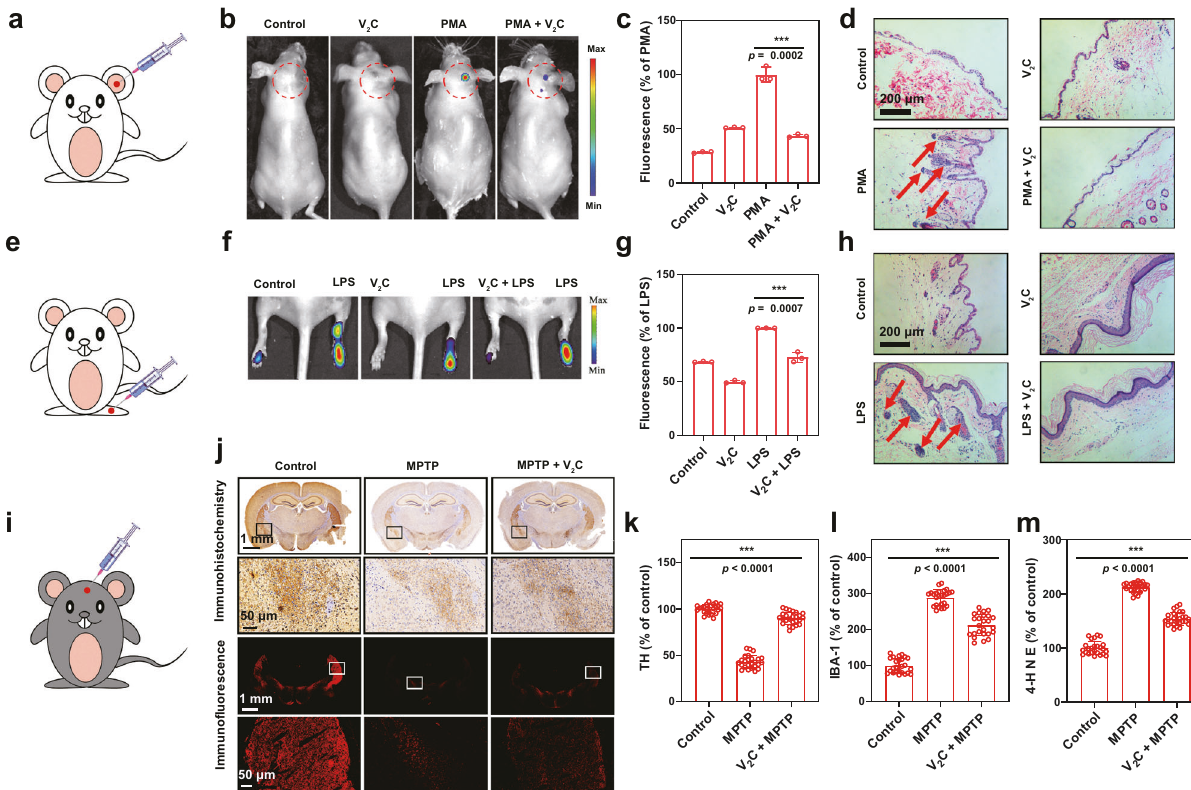
Fig. 9 In fl ammation and neurodegeneration therapy based on V 2 C MXenzyme. a Scheme of ear in fl ammation model. b In vivo fl uorescence imaging of mice with different treatments to evaluate the effect of V 2 C MXenzyme on ROS scavenging in PMA-induced ear in fl ammation. c Corresponding radiant ef fi ciency of the fl uorescence images acquired in the live mice after different treatments ( n = 3 for each group). d H&E-stained images of mice ears after different treatments. e Scheme of ankle in fl ammation model. f In vivo fl uorescence imaging of mice with different treatments to evaluate the effect of V 2 C MXenzyme on ROS scavenging in LPS-induced ankle in fl ammation. g Corresponding radiant ef fi ciency of fl uorescence images acquired in the live mice after different treatments ( n = 3 for each group). h H&E-stained images of mice ankles after different treatments. i Scheme of PD model treatment. j Immunohistochemistry and immuno fl uorescence images of TH expression in the brains of mice after different treatments (coronal plane). Expression levels of k TH, l IBA-1, and m 4-HNE in each treatment group (coronal plane) ( n = 25 for each group), quanti fi cation represents the ratio of the experimental group to control. Data presented as mean ± SD and asterisks indicate signi fi cant differences (*** p < 0.001) using one-way analysis of variance (ANOVA). A representative image of three replicates from each group is Thermodynamically, the dismutation of O 2 − (cid:129) is concerned with the E(O 2 /O 2 − (cid:129) ) and E(O 2 − (cid:129) /H 2 O 2 ) are 0.91 and − 0.18 V, respectively 57 .